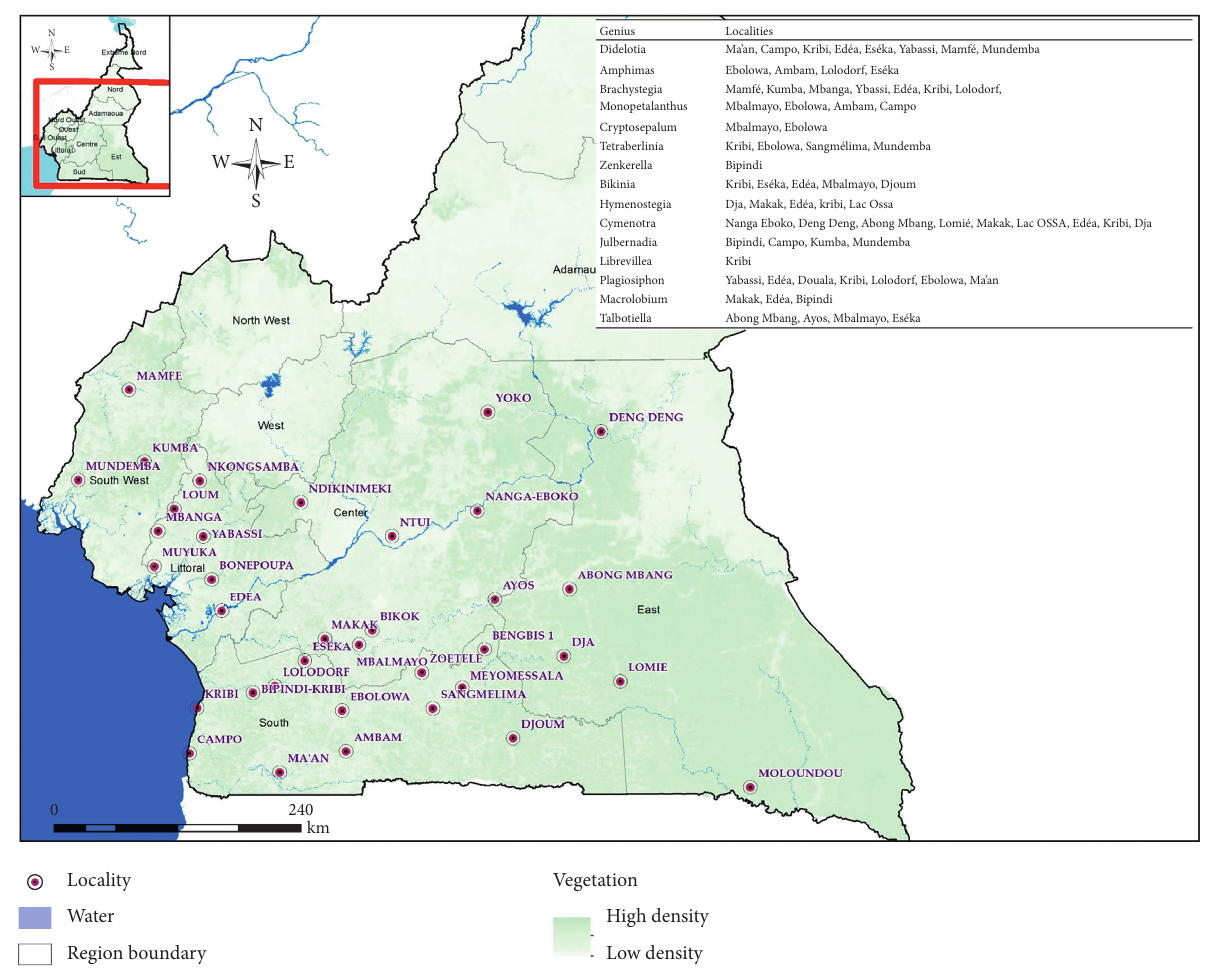
Figure 1: Distribution of Ekop species in Cameroon (adapted from